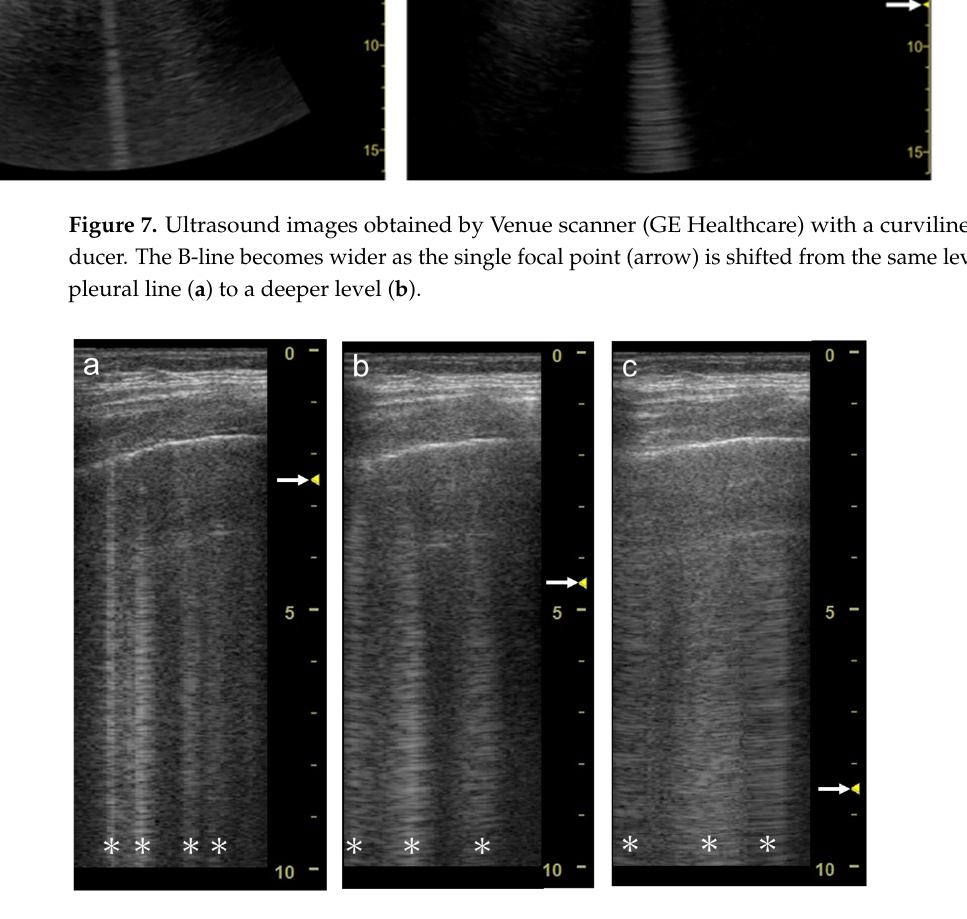
Figure 8. Ultrasound images obtained by LOGIQ V scanner (GE Healthcare) with a linear transducer in cardiogenic pulmonary edema. As the single focal point (arrow) is shifted from a level near the pleural line ( a ) to deeper levels, each B-line becomes wider ( b ), with the B-lines finally overlapping each other ( c ). Asterisks indicate B-lines.